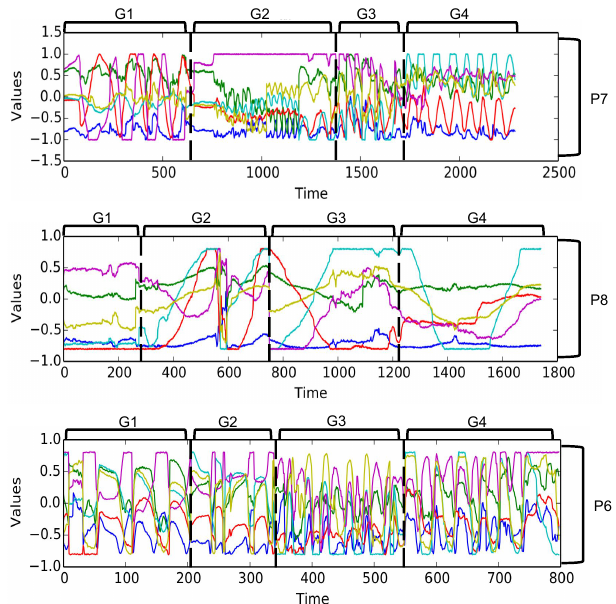
Figure 3. Three examples of four gestures, input behaviours, from participants P6, P7, and P8 used for the training of the Echo State Networks (ESN). The four different gestures are labelled with G1, G2, G3 and G4 at the top of each figure. Lines represent the 6 dimensions of the input signal of the Leap Motion device, plotted against time. It is possible to appreciate: (a) the visible differences in the quality of the input sequences and (b) the different lengths in time. That is, the different span along the